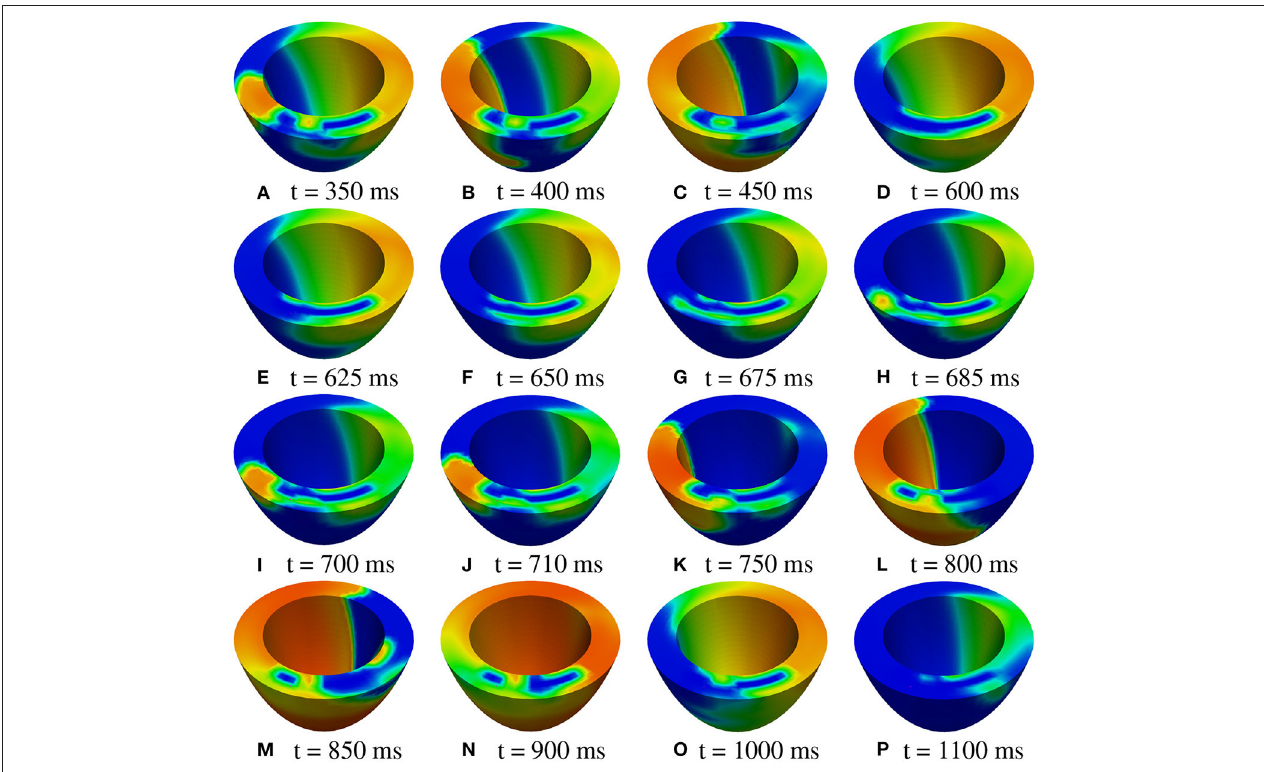
FIGURE 12 | Patient #2. M2 stimulation. (A–P) Transmembrane potential snapshots (t = 350–1,100 ms) on a transmural section. t = 0 corresponds to the S3 stimulus. The S4 stimulus is applied at t = 300 ms. The colorbar is the same as in Figure 5 .